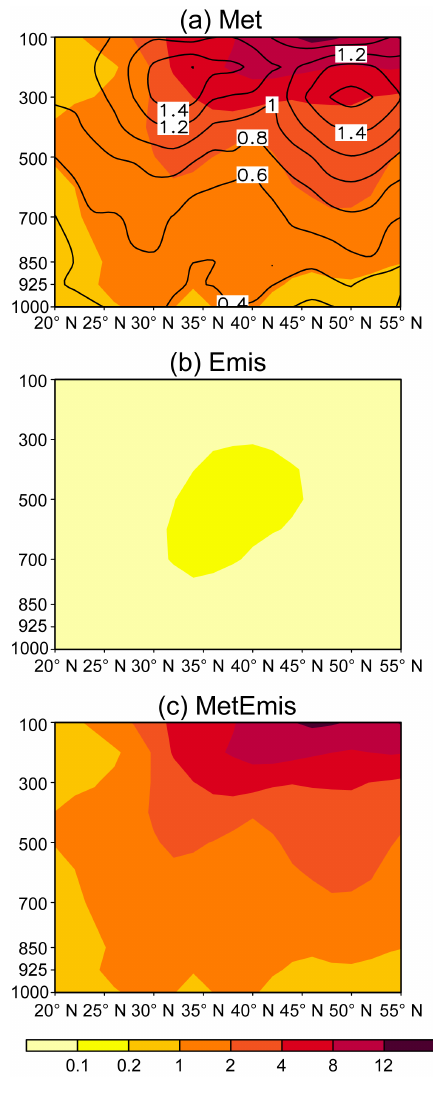
Figure 9. The pressure–latitude cross sections along 135 ◦ E of the MAD values for the detrended annual O 3 outflow fluxes and zonal winds from 1986–2006 in the Met, Emis, and MetEmis simulations. The MAD values for O 3 mass fluxes are shown by the colored shad- ing (kgyr − 1 m − 2 ) , and the MAD values for the winds are repre- sented by the contours (ms − 1 )